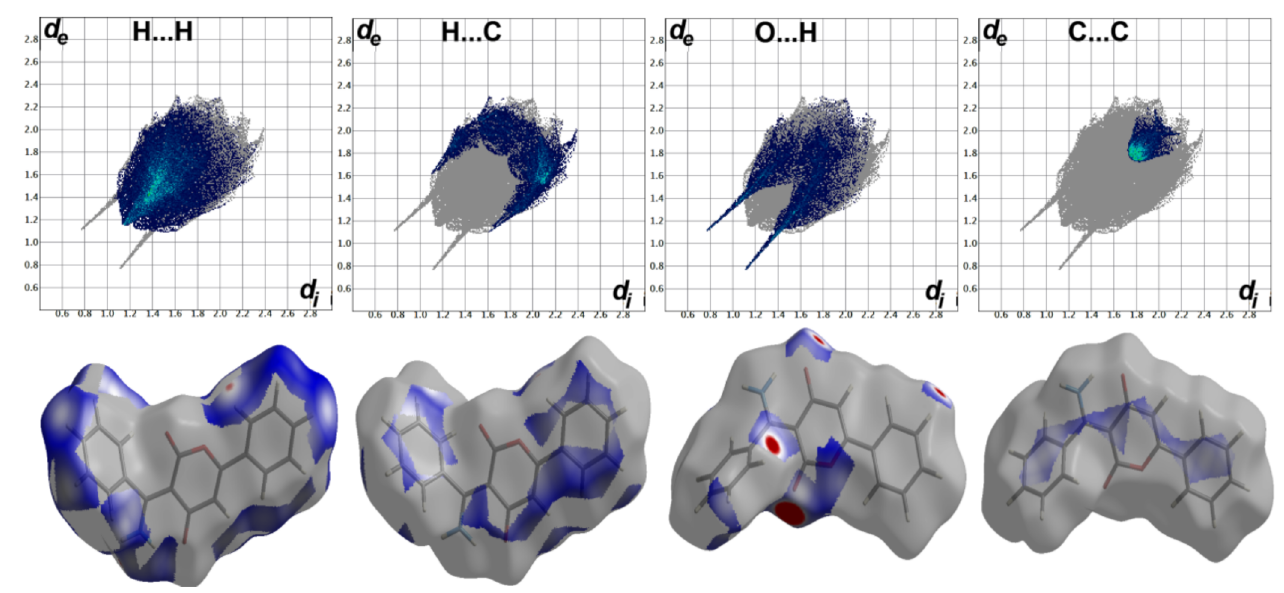
Figure 8. Decomposed fingerprint plots and d norm Hirshfeld surfaces of the most abundant interactions in 3 . In case of compound 4, the percentages of the O...H, H...C, H...H and C...C contacts are 18.2, 21.0, 4.4 and 54.4%, respectively using Hirshfeld calculations. All appeared significant with interaction distances shorter than the VDWs radii sum of the two atoms included in these interactions except the H...H contacts which are slightly longer than the sum of the VDWs radii of two hydrogen atoms (Figure 9). The shortest interaction distances are O2...H17 (2.431 Å), H22A...C17 (2.623 Å), H16...H22A (2.44 Å) and C2...C10 (3.252 Å), respectively.